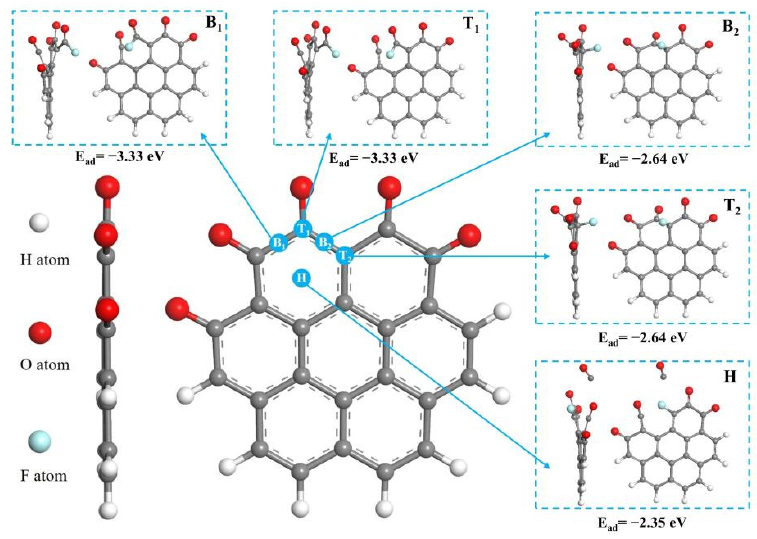
Figure 7. Adsorption energy and structure change of F atom adsorbed on Model A.